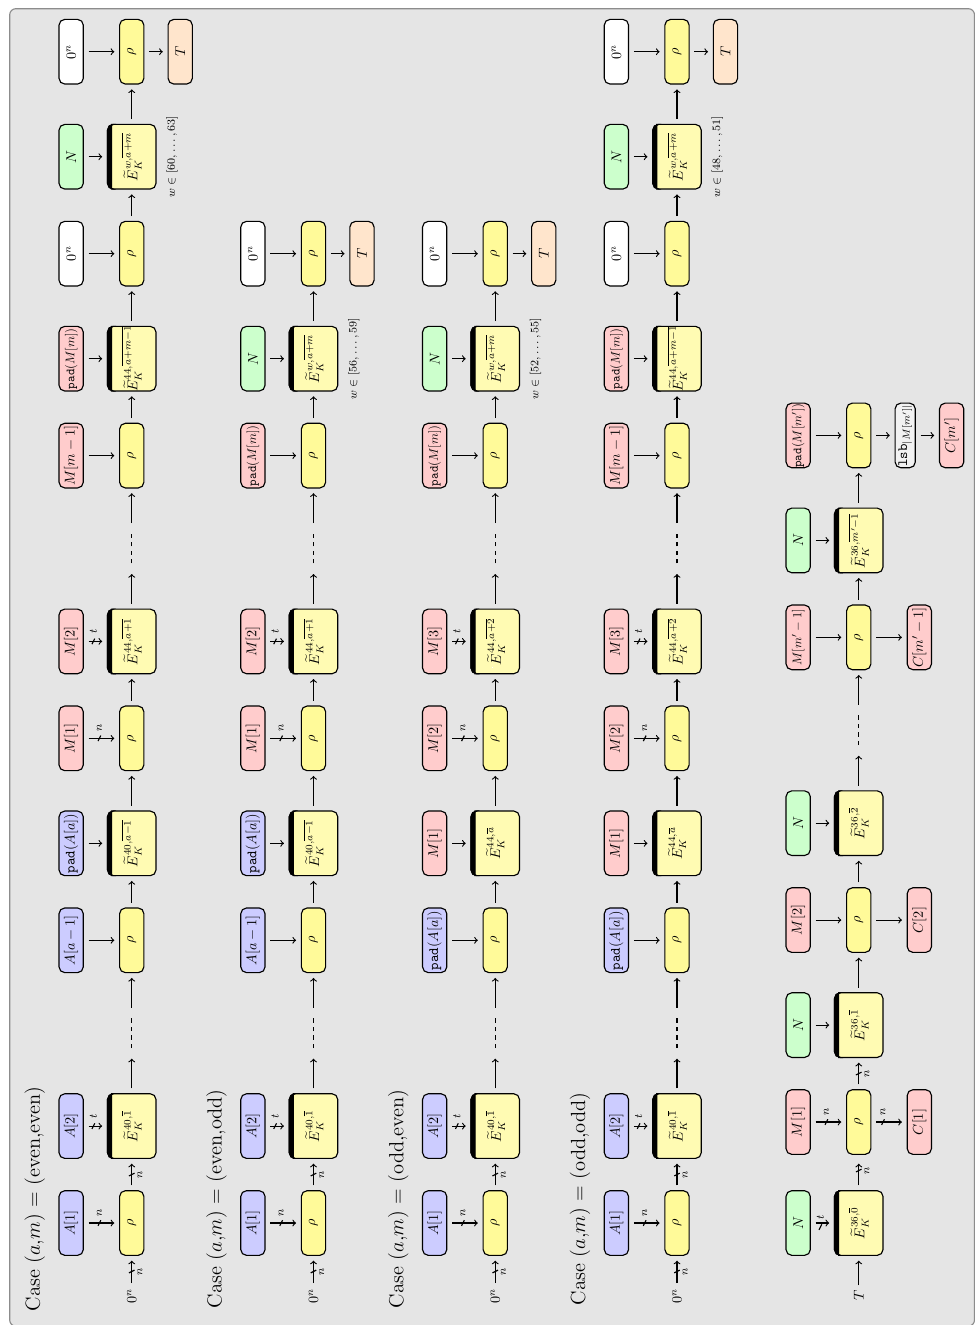
Figure 5: The Romulus-M misuse-resistant AE mode. (Top) process of AD with an even/even, even/odd, odd/even, odd/odd number of AD blocks and M blocks, respectively. (Bottom) Encryption. We use Romulus - M 1 as working example. For other Romulus-M members, the values of the bits b 7 and b 6 in the domain separation need to be adapted